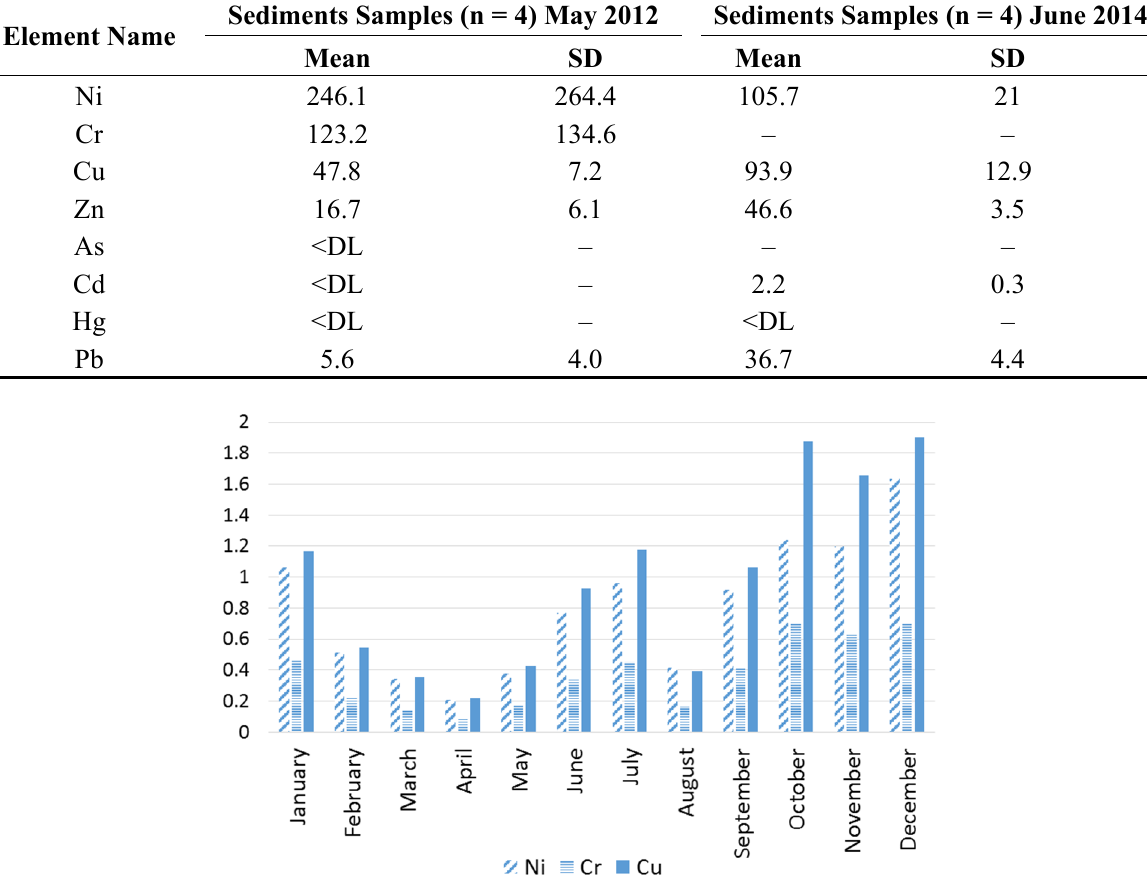
Figure 13. Monthly distribution of G2 met index values for Ni, Cr, and Cu in Kouris reservoir. An indicative overview of the estimated risk values in Kouris basin in comparison to the measured concentration values in the sediment samples for Ni (in mg kg − 1 ) in the Kouris reservoir, is provided in Figure 14.